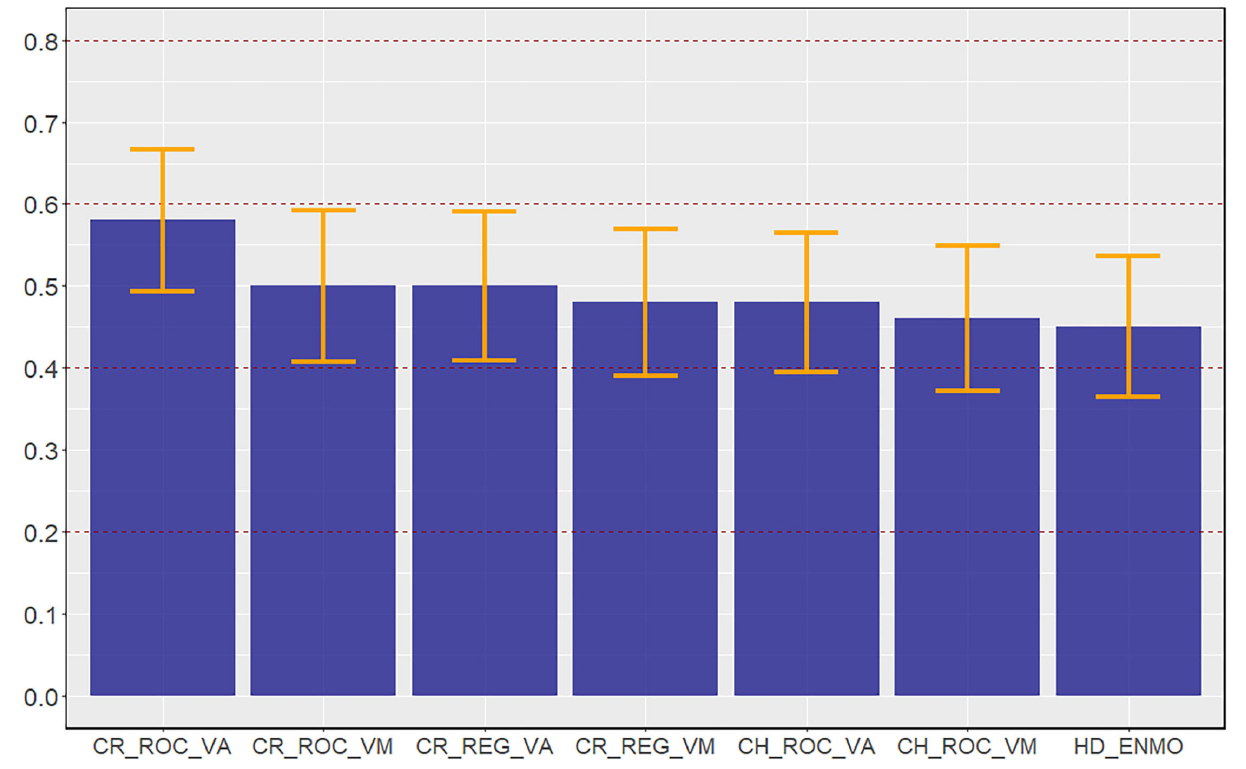
FIGURE 1 | Kappa statistics for the seven youth-specific ActiGraph cut-points for the